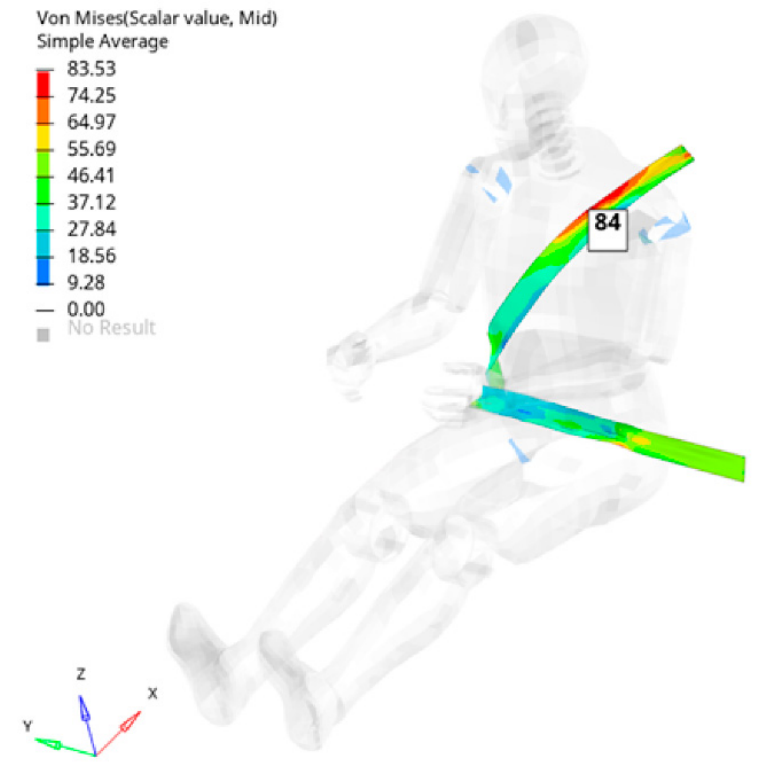
Figure 12. Stress in the belt when T = 0.025 s (in MPa).